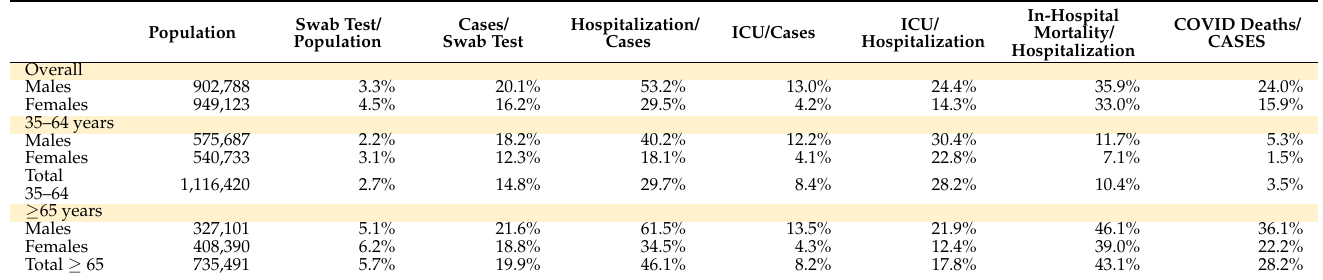
Table A2. Distribution of our sample population by age and sex and ratios in selected outcomes.